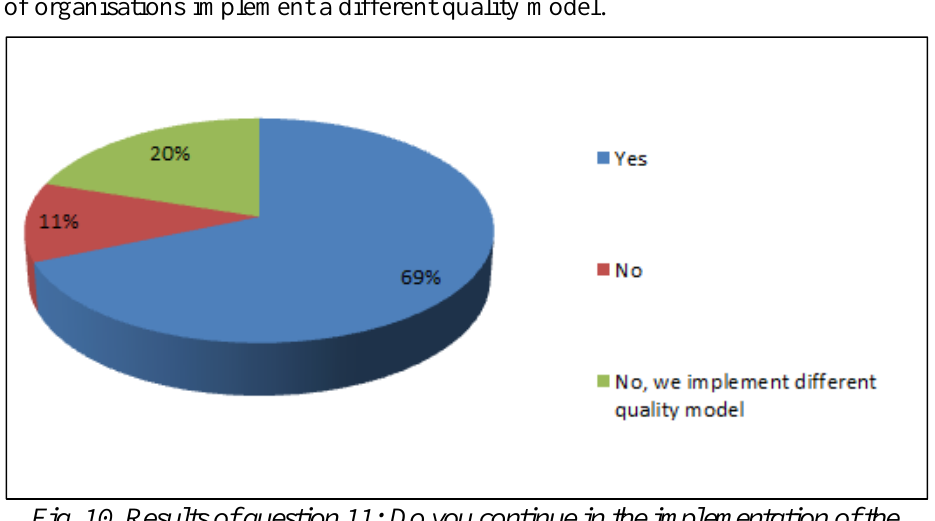
Fig. 10 Results of question 11: Do you continue in the implementation of the quality model you have participated in the